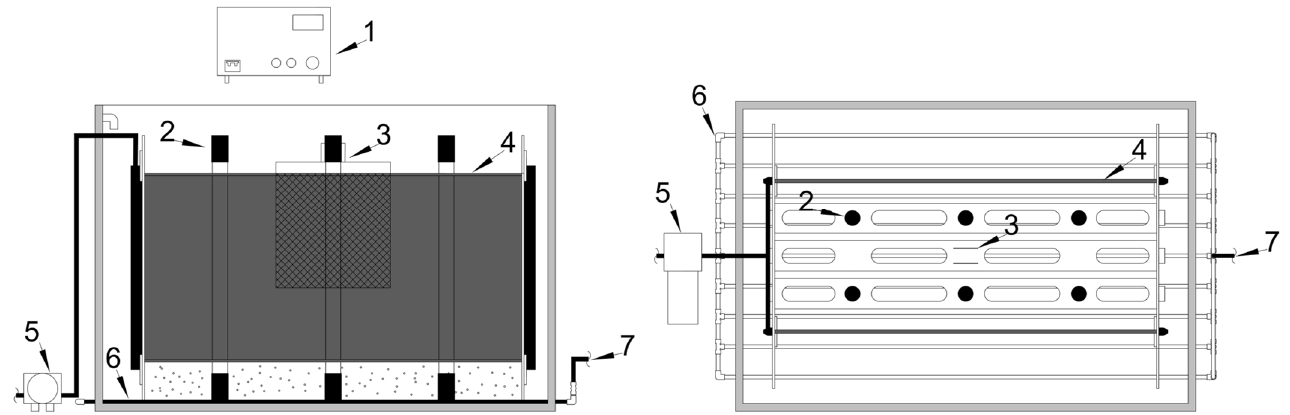
Figure 10. Schematic of the UV/electrochemical oxidation/flat membrane reactor (left: front view, right: top view). 1: DC power supply, 2: UV lamp (six lamps in total, each covered by a quartz glass water jacket), 3: electrode, 4: flat ceramic microfiltration membrane, 5: self-priming pump, 6: aeration device, 7: connection to an air compressor (not shown in the diagram).